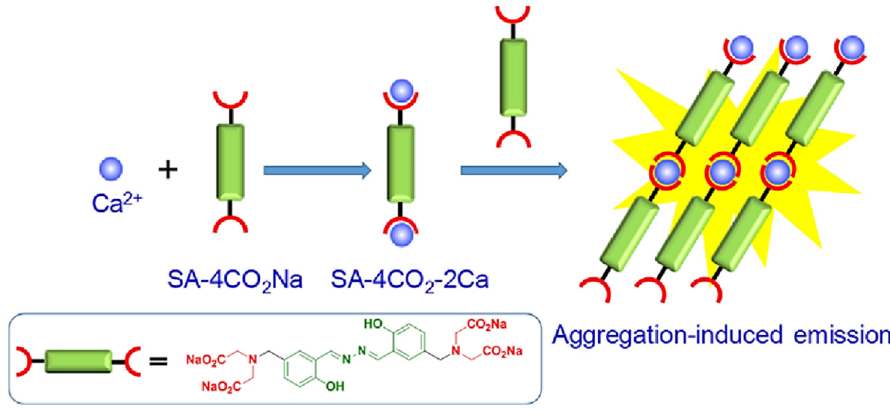
Figure 5. Schematic illustration of the AIE active probe SA-4CO 2 Na for intracellular detection of Ca 2+ . Reprinted from reference [40] with the permission of the American Chemical Society.